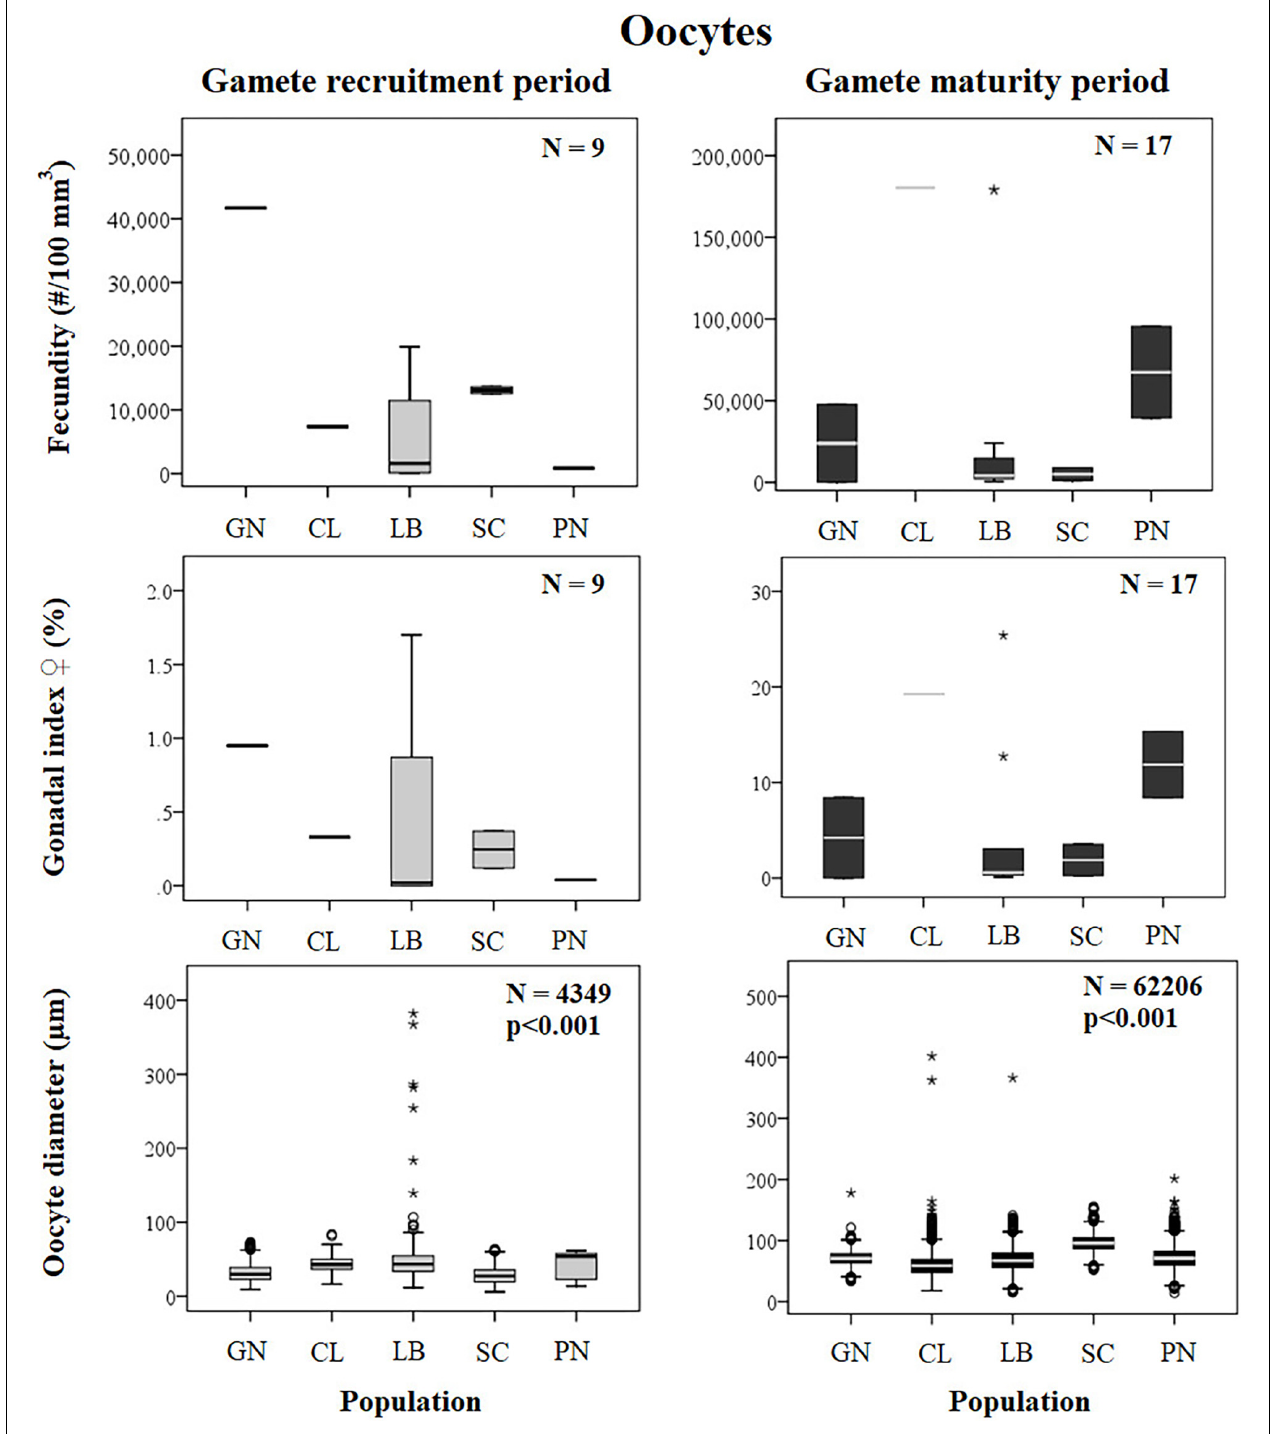
FIGURE 4 | Oocytes. Boxplots of reproductive parameters per study site (GN Genova; CL Calafuria; LB Elba Island; SC Scilla; PN Pantelleria Island) during the gamete recruitment and gamete maturity periods. Each boxplot diagram shows the median (solid horizontal line), the first and third quartiles (box outline), the minimum and maximum values (whiskers) and the outliers (stars and circles). N , polyp number for fecundity and gonadal index, oocyte number for diameter; p , significance of the ANOVA/Kruskal–Wallis test.